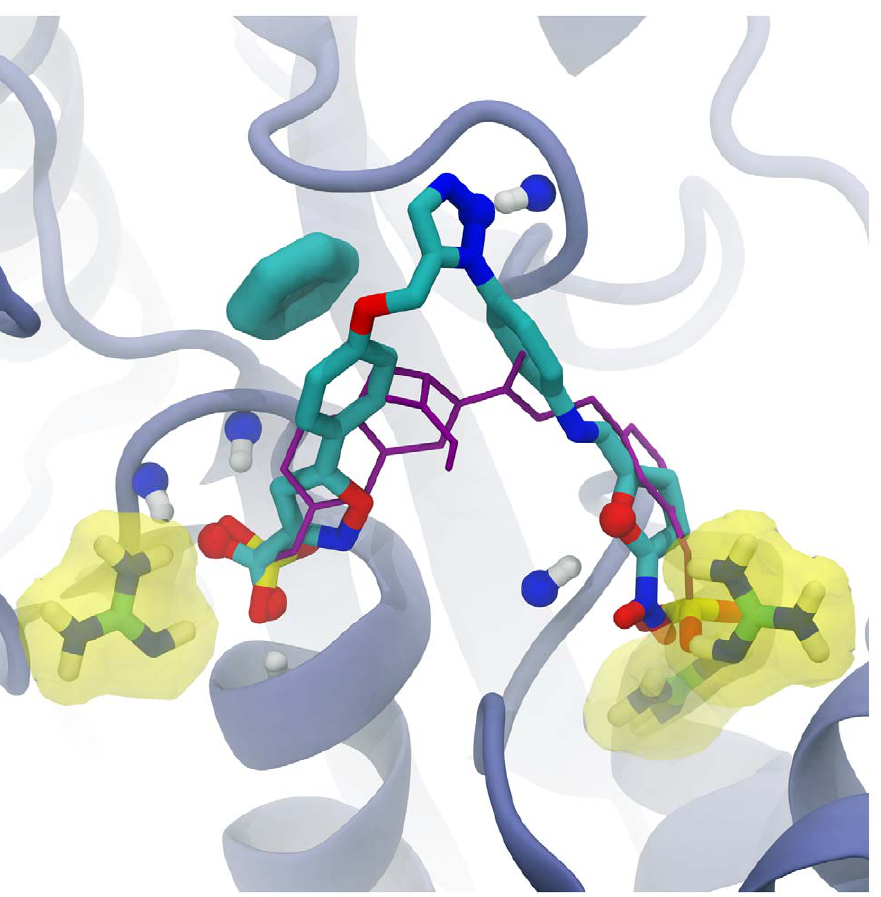
Figure 2. The top-scoring predicted PTP1B ligand (in licorice representation), docked into the receptor active site. Protein residues that participate in electrostatic interactions are highlighted in yellow. Atoms that participate in receptor-ligand hydrogen bonds are shown in ball- and-stick representation. The aromatic ring of the receptor tyrosine residue that participates in p - p stacking and T-stacking interactions with the ligand is shown in thick licorice representation. The crystallographic pose of a known inhibitor is shown in purple, with key sulfonate moieties shown colored by element in licorice representation. Portions of the protein have been removed to facilitate visualization. Figure S1 The click-chemistry reactions that can be simulated in silico using AutoClickChem. (PDF) Text S1 Contains additional details describing the pymolecule toolbox, the creation of the large virtual library of easily synthesizable compounds, and the docking protocol used in the current work. Further descriptions of each of the chemical reactions built into AutoClickChem are also provided, with extensive references.